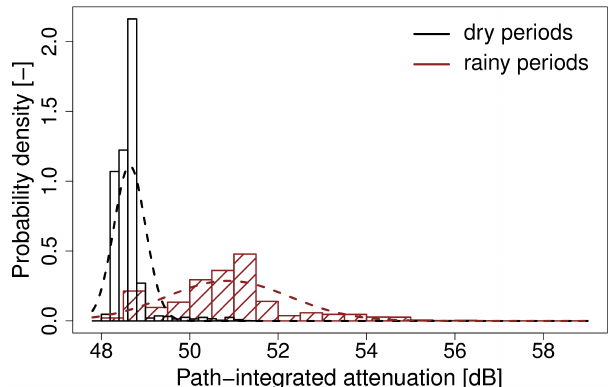
Fig. 5. Empirical probability density functions of attenuation values for dry and rainy periods (for dataset 1). The dashed lines represent Fig. 15. Empirical probability density functions of attenuation val- the fitted densities of a Gaussian distribution with same mean and ues for dry and rainy periods (for dataset 1). The dashed lines repre- variance as the samples. The dry and rainy periods are derived from sent the fitted densities of a Gaussian distribution with same mean the disdrometer and variance as the samples. The dry and rainy periods are derived Fig. 13. Illustration of the classification performances for the uni- from the disdrometer data. variate Markov switching algorithm (MSU), the simple threshold, the Factor Graph and the moving window on a subset of dataset 1 (stationary case). Displayed are the observations from channel 1. The time is given in UTC.